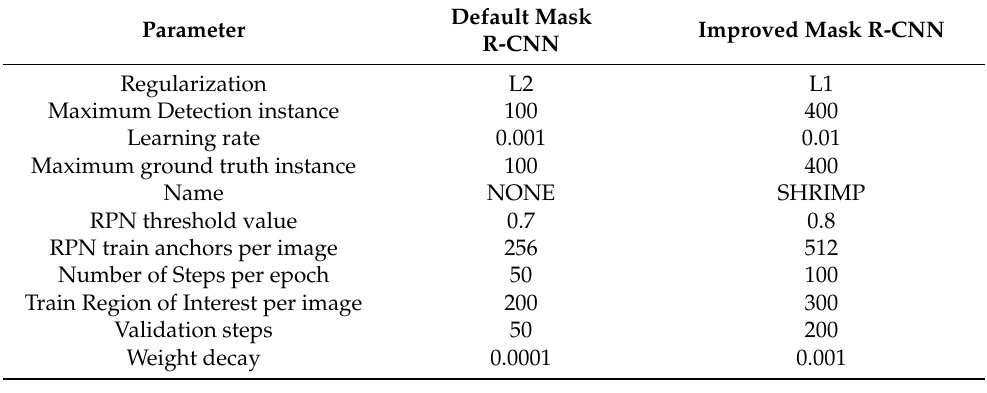
Table 2. Experimental parameters.